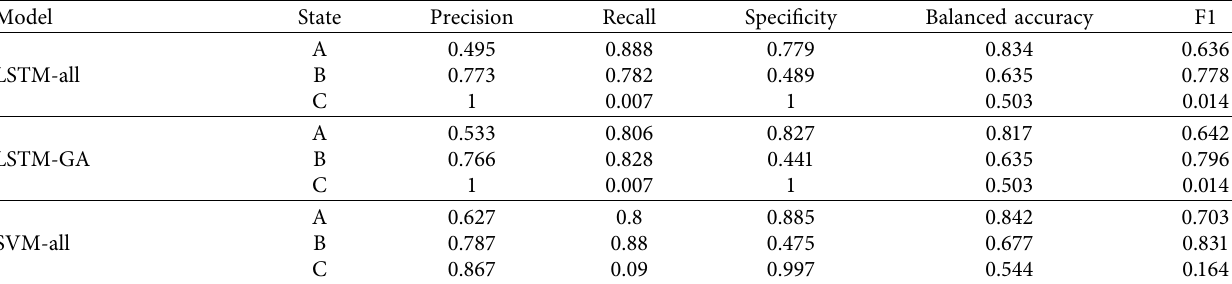
Table 8: Evaluation metrics for predicting each traffic